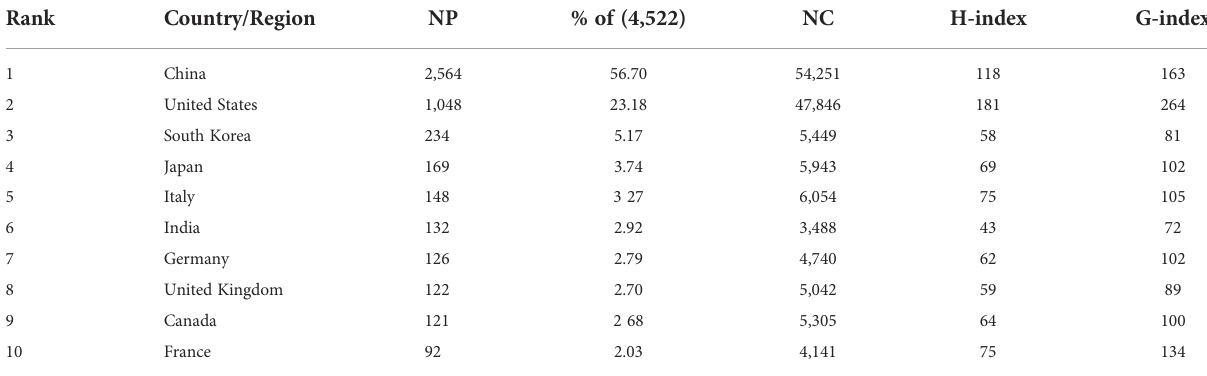
TABLE 1 Top 10 countries with the most published research on autophagy in lung disease.